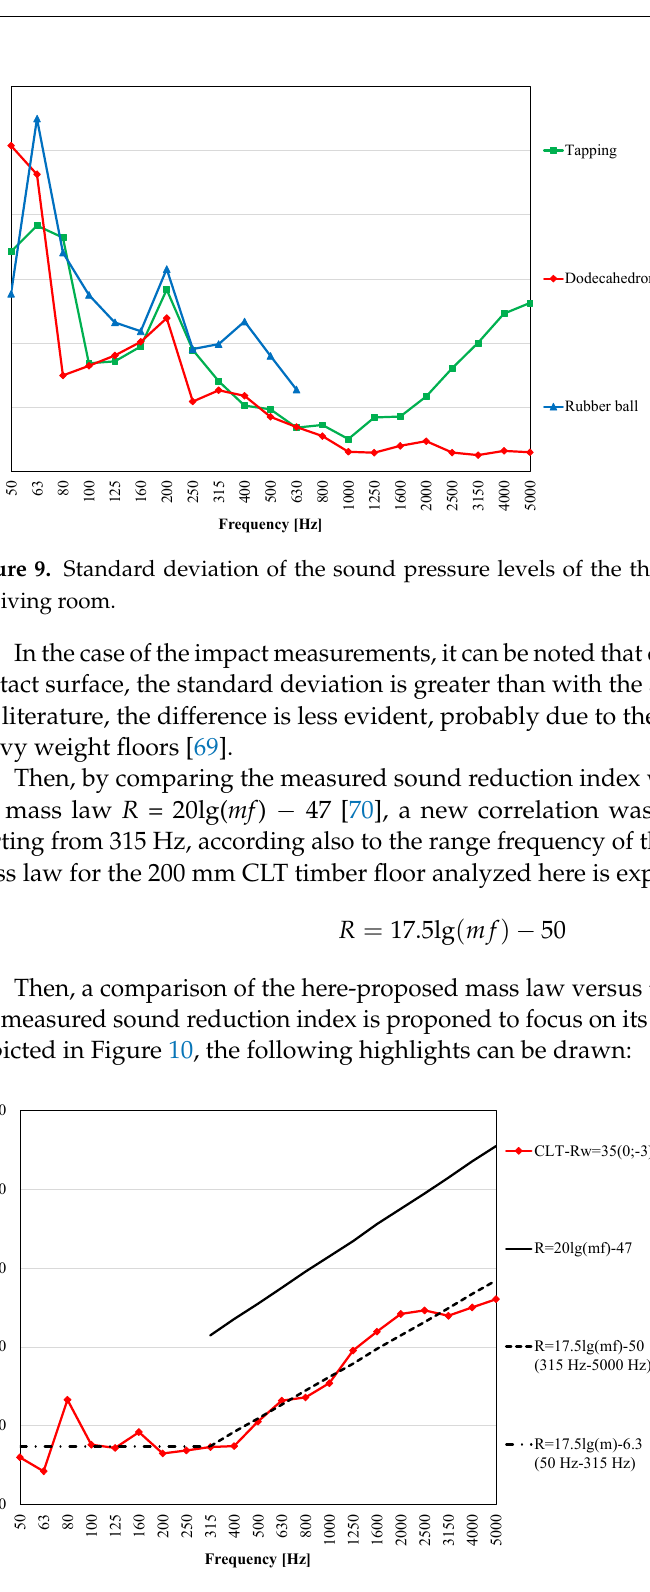
Figure 10. Measurements of sound reduction index for the 200 mm CLT floor and comparison with proposed mass law and R = 20lg( mf ) − 47.